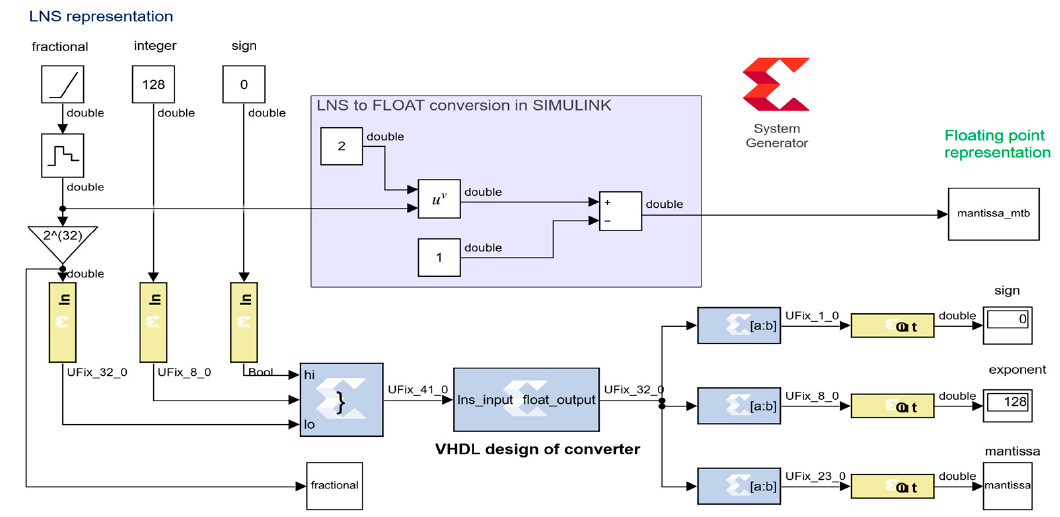
Figure 5. Converter simulation and verification in the Matlab–Simulink environment.